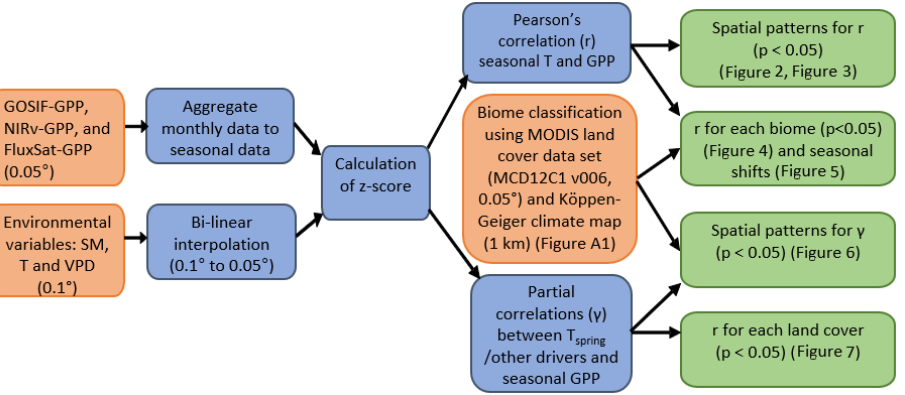
Figure 1. The diagram of the study workflow. The input data (depicted in orange color) underwent pre-processing and statistics calculations (depicted in blue color), eventually leading to the main results (depicted in green